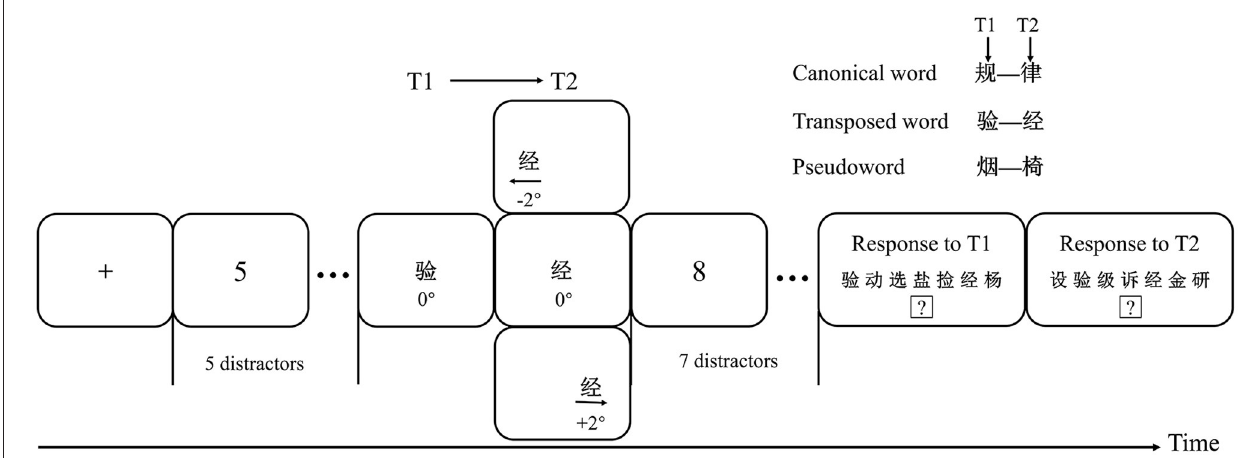
FIGURE 1 | Schematic depiction of the stimuli presentations used in the present experiment. The T1 and T2 combination randomly formed a canonical word, transposed word, or pseudoword, with T1 presented at the center (0 ◦ ) and T2 presented randomly either at the center (0 ◦ , CVF), 2 ◦ to the left or right of center (LVF, RVF). The depicted trial is one in which T1 (“ ”) and T2 (“ ”) could form a meaningless transposed word in the order of “T1 + T2” but could form a meaningful word in the reverse sequence [“ ” (T2 + T1), meaning